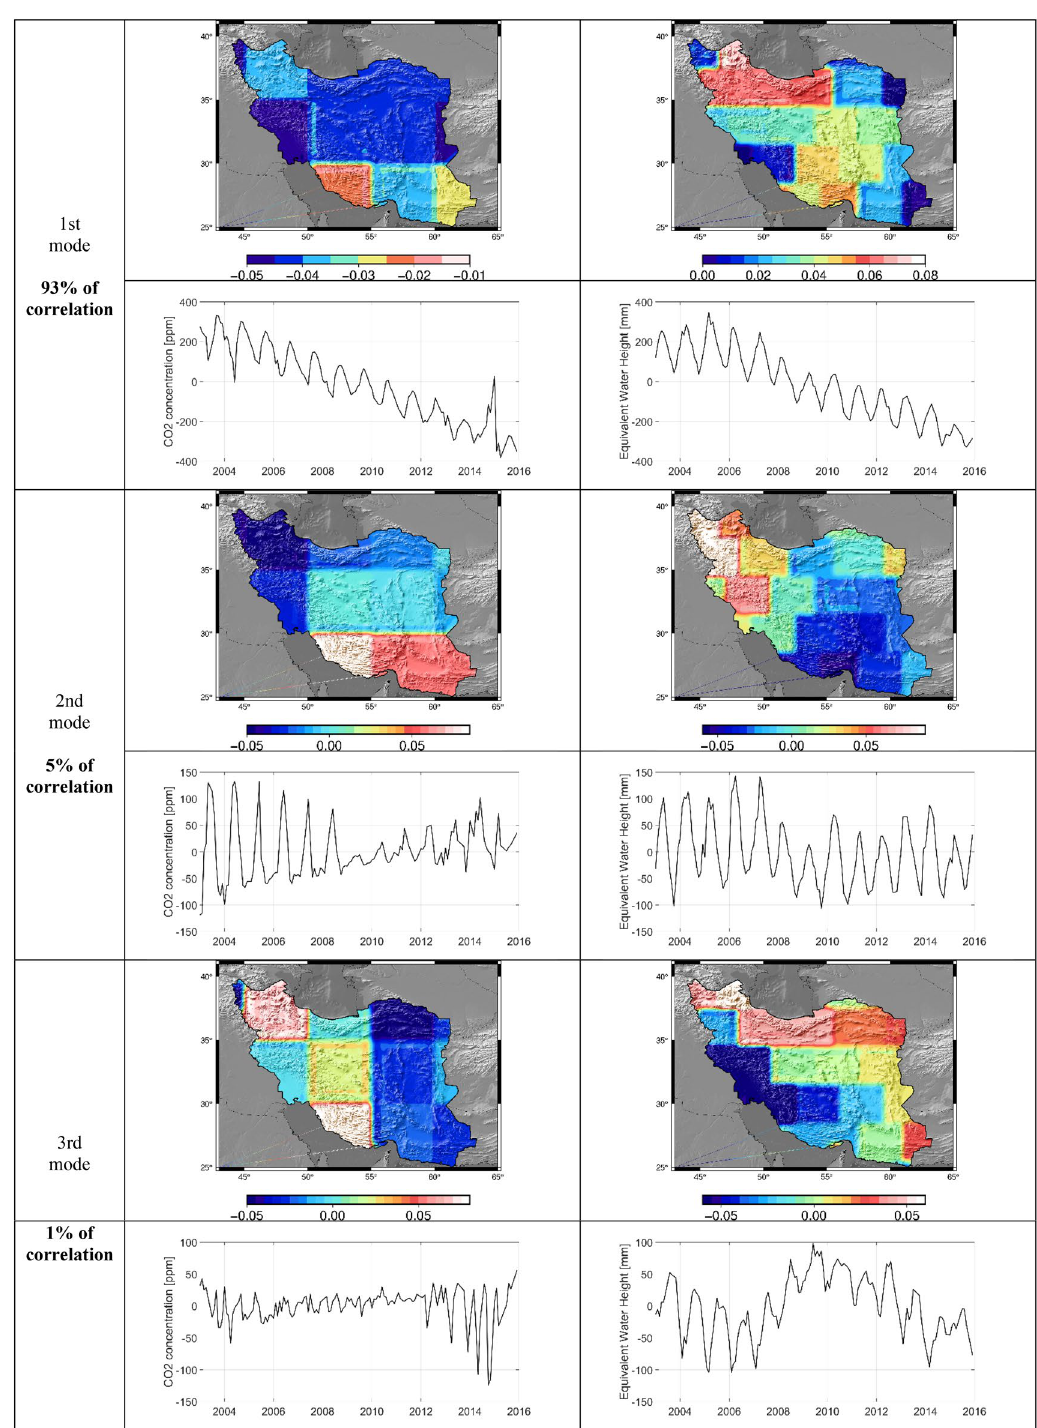
Figure 7. Results of CCA analysis between CO 2 and EWH anomaly for the first three modes carrying 99% of the correlation. For each mode, time series and maps of canonical modes are shown for both CO 2 concentration (left) and EWH anomaly from GRACE